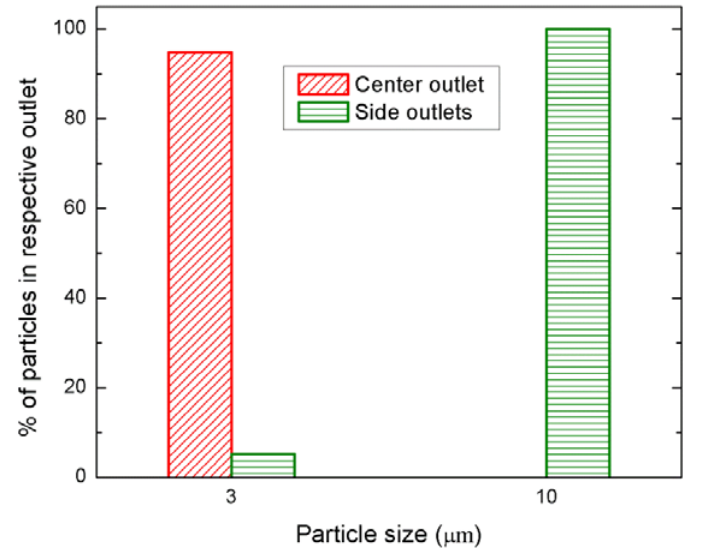
Figure 9. Distribution of each of the two particle sizes (3 and 10 μ m) over the two outlets.